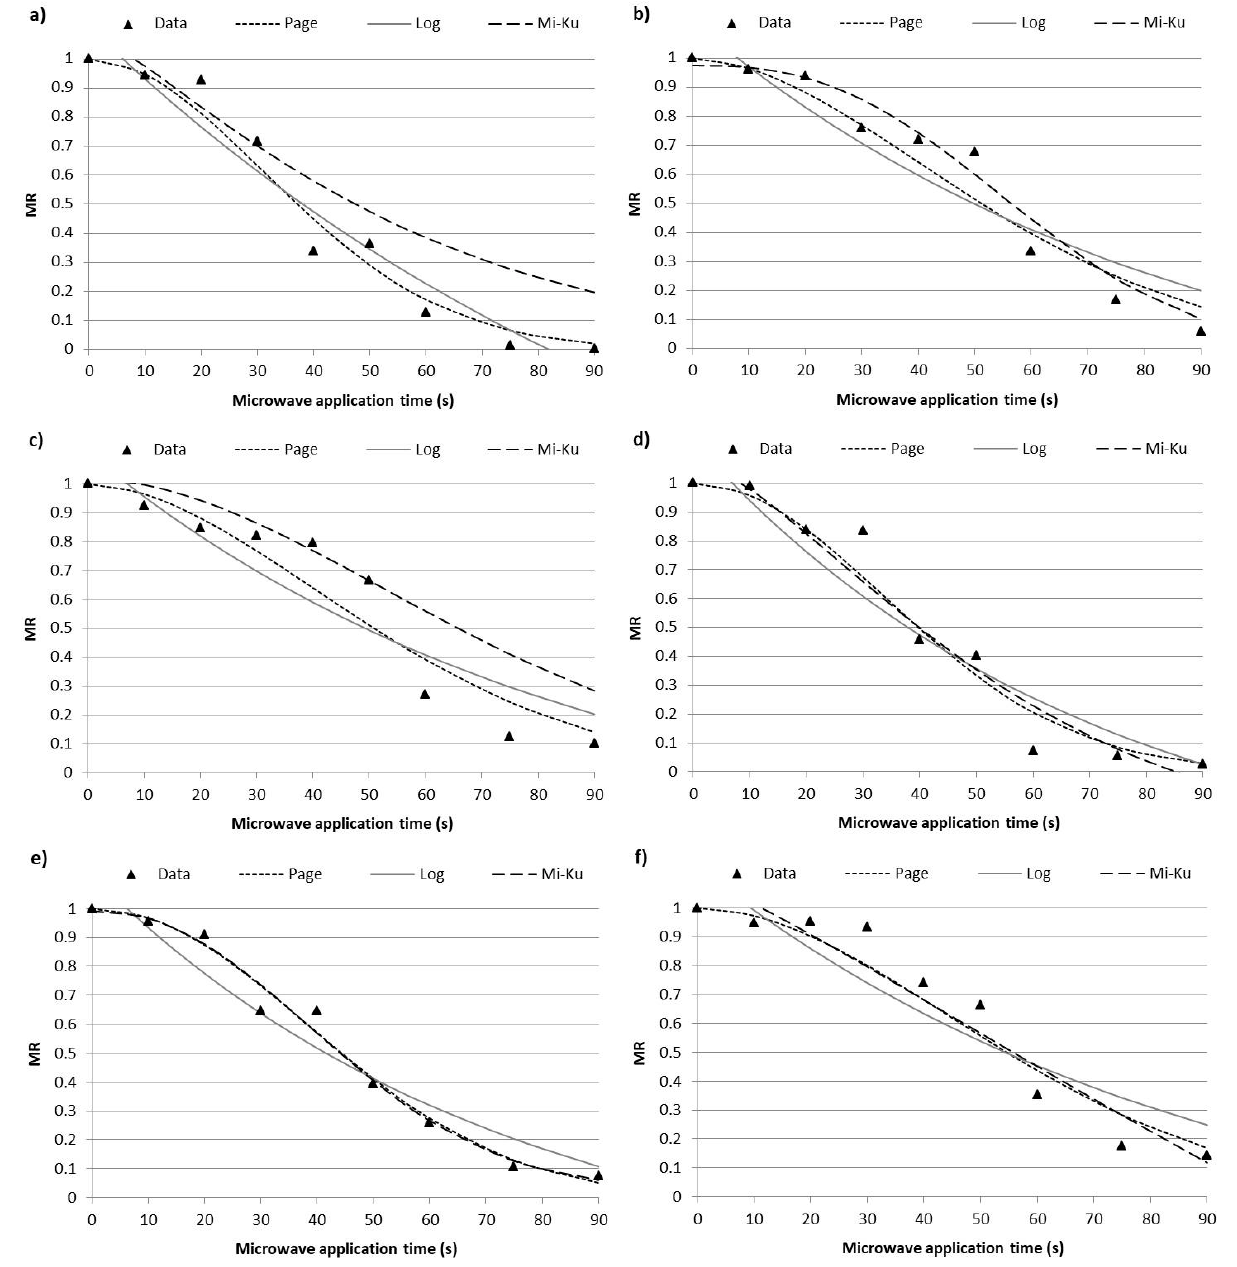
Figure 2. Microwaving expansion kinetics of corn pellets with a different water and beetroot content of its mixtures ( a ) Control snack with 25% water content in mixture, ( b) Control snack with 30% water content in mixture; ( c ) Snack with 25% water content and 5% beetroot content in mixture, ( d ) Snack with 30% water content and 5% beetroot content in mixture, ( e ) Snack with 25% water content and 10% beetroot content in mixture, and ( f ) Snack with 30% water content and 10% beetroot content in mixture, adjusted to Page, Logarithmic (Log), and Midilli–Kucuk (Mi-ku) models.